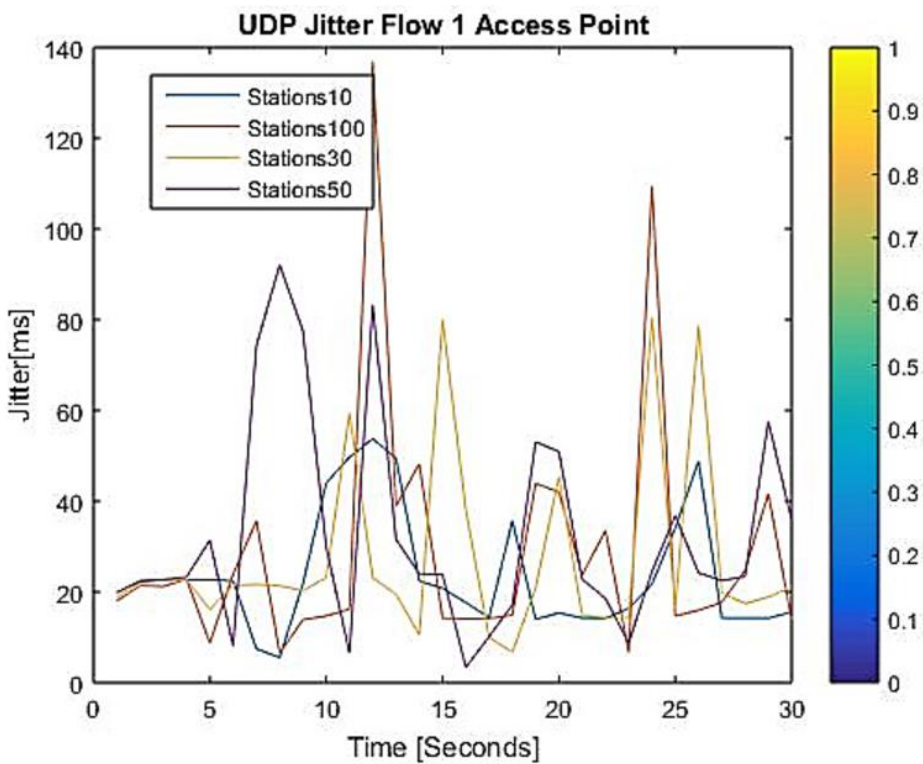
Figure 13. UDP bandwidth for 4 access points.